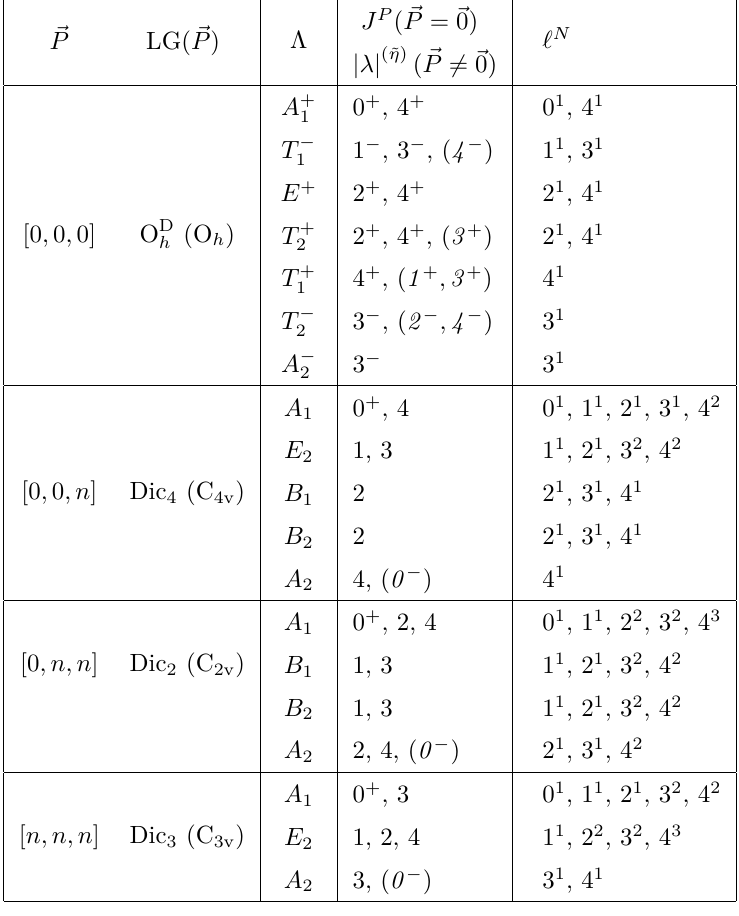
Table 3 . The pattern of subductions of pseudoscalar-pseudoscalar partial waves, ‘ ≤ 4 , into lattice irreps, Λ , when the pseudoscalars have unequal mass, e.g. DK or D ¯ K (from table III of ref. [36]). Here N is the number of embeddings of this ‘ in the irrep and n is a non-zero integer. LG ( ~P ) is the double-cover little group and the corresponding single-cover little group relevant for only integer spin is given in parentheses. Also shown are the various J ≤ 4 or | λ | ≤ 4 that appear in each of the relevant irreps. The J P values and | λ | ˜ η = 0 − in italics are in the “unnatural parity” [ P = ( − 1) J +1 ] series and do not contribute to pseudoscalar-pseudoscalar